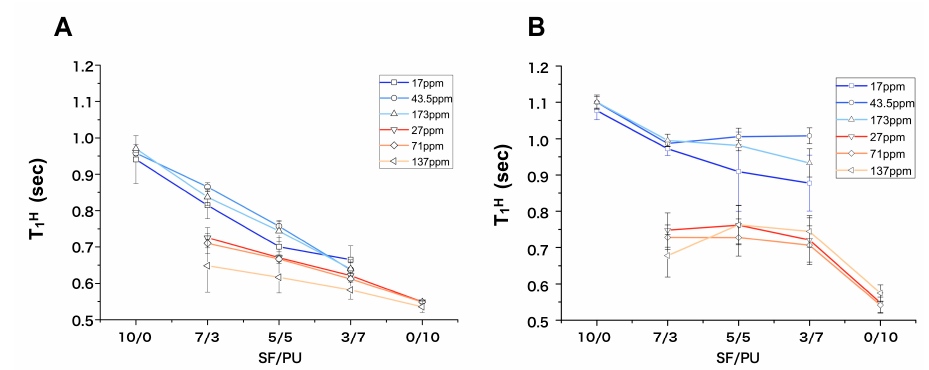
Figure 4. T 1H plot of SF (C=O, 173 ppm; Gly C α , 43.5 ppm; Ala C β , 17 ppm) and PU (phenyl groups,